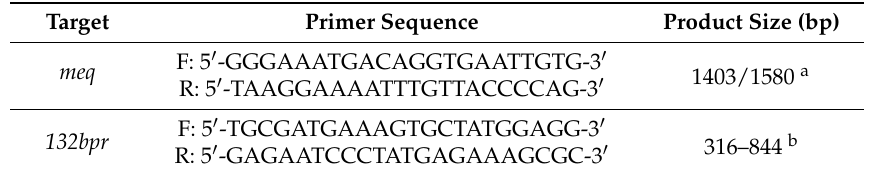
Table 1. Polymerase chain reaction (PCR) primers for Marek’s disease virus (MDV) strain